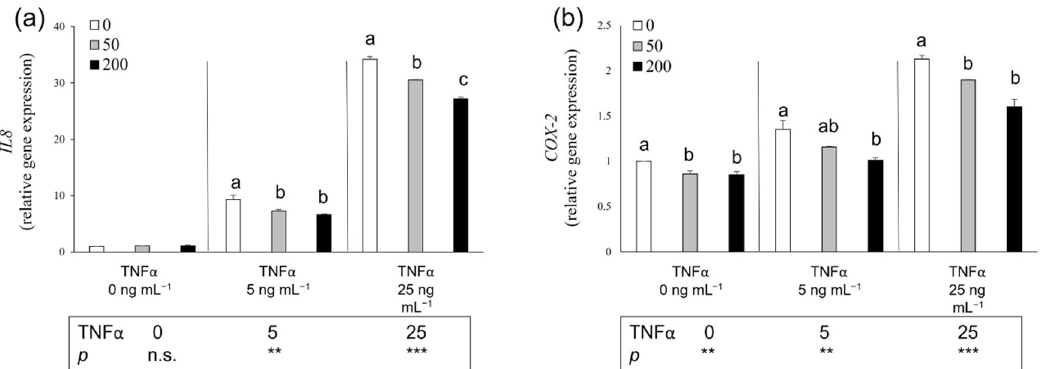
Figure 6. Relative gene expression of ( a ) IL-8 and ( b ) COX-2 in HT-29 cells 1h pre-treated with 0, 50, and 200 μ g mL − 1 of Salicornia extracts and exposed for 24 h to 0, 5, and 25 ng mL − 1 of TNF α . Data represent the mean ± SE ( n = 4). For each TNF α concentration, the presence of different letters indi- cates significant differences according to one-way ANOVA followed by Tukey’s test ( p ≤ 0.05). Sig- nificance level: ** p ≤ 0.001; * p ≤ 0.01; n.s. = not significant.